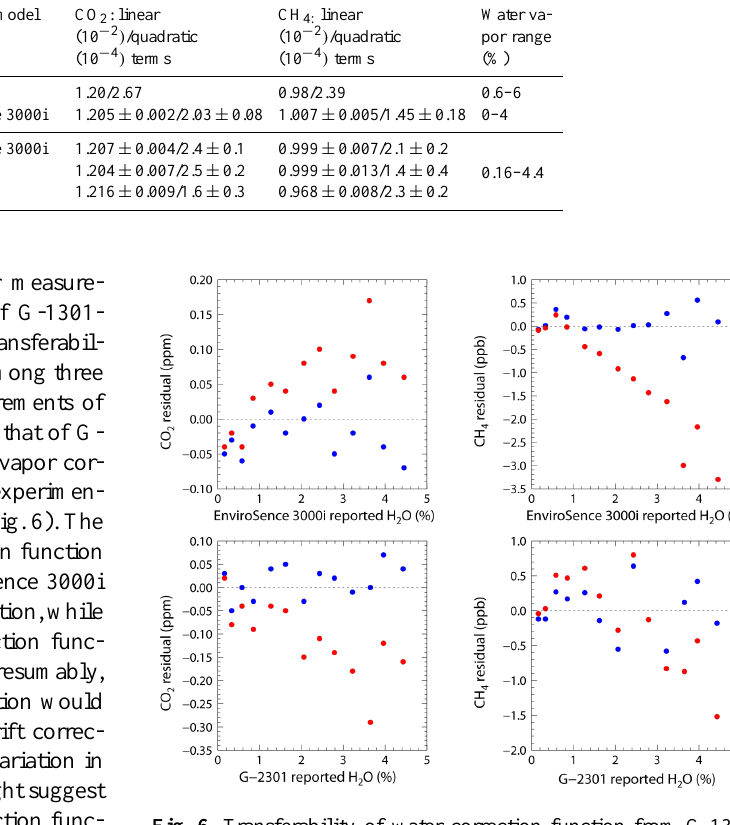
Table 3. Water correction functions for three different WS-CRDS instruments along with the correction functions from past studies.